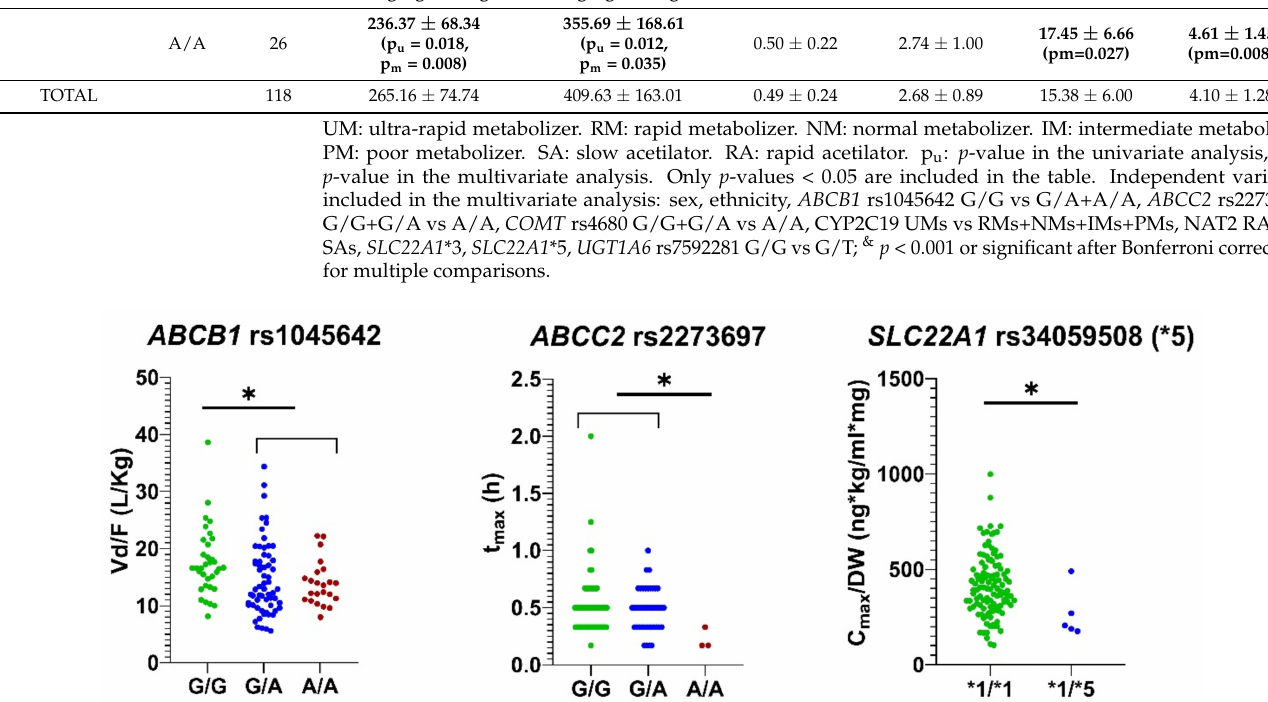
Figure 1. Box plots representing significant associations between genotypes and pharmacokinetic parameters after Bonferroni correction for multiple comparisons. Left panel: Vd/F according to ABCB1 rs1045642 genotype; center panel: tmax according to ABCC2 rs2273697 genotype; right panel: C max /DW according to SLC22A1 rs34059508 genotype (*1/*1 equals to G/G, *1/*5 equals to G/A). * p < 0.001 after multivariate analysis (independent variables: sex, ethnicity, ABCB1 rs1045642 G/G vs G/A+A/A, ABCC2 rs2273697 G/G+G/A vs A/A, COMT rs4680 G/G+G/A vs A/A, CYP2C19 UM ultra-rapid metabolizer (UM) vs rapid metabolizers (RM) + normal metabolizers (NM) + intermediate metabolizers (IM) + poor metabolizers (PM), NAT2 RA vs. SA, SLC22A1 *3, SLC22A1 *5, UGT1A6 rs7592281 G/G vs.